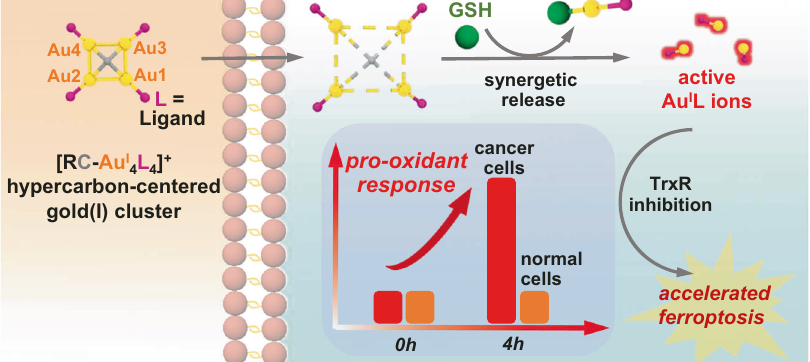
Fig. 1 | Schematic of pharmacological mechanisms of hypercarbon-centered gold(I) cluster